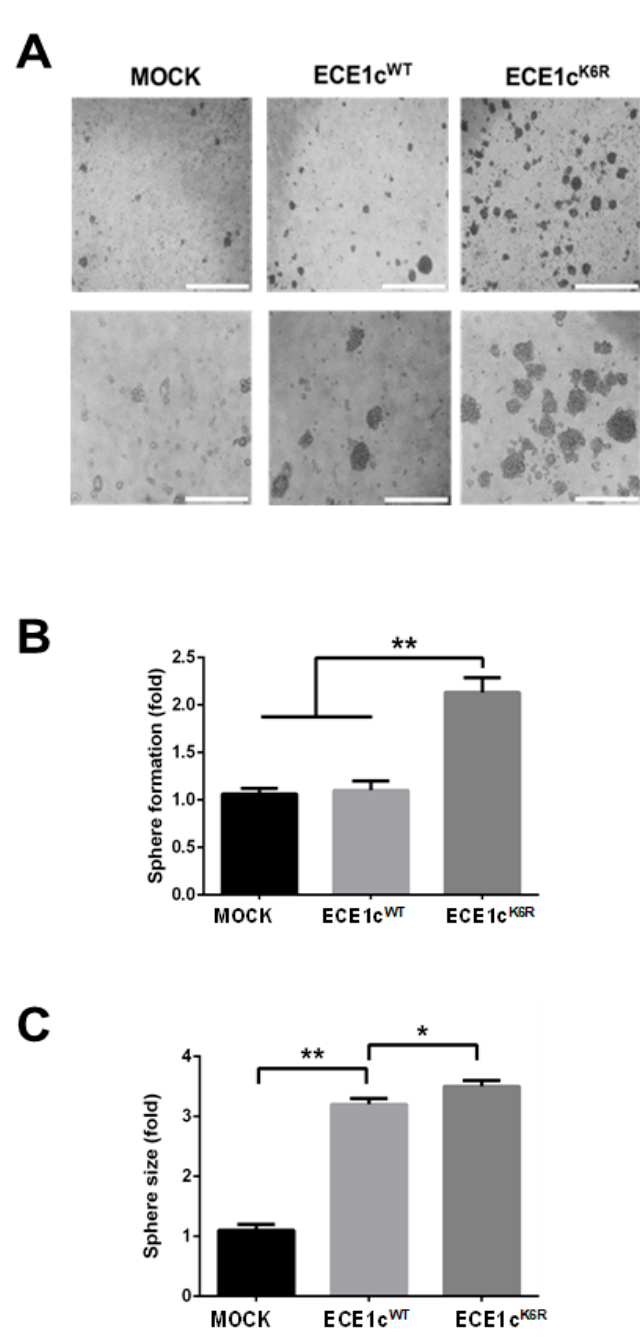
Figure 4. GSC enrichment was promoted by ECE1c K6R . ( A ) GSC enrichment was assessed using U87MG clone cells expressing ECE1c WT or ECE1c K6R and mock cells after 24 h of growth in a neurobasal medium for 7 days (i.e., a neurosphere-forming saturated condition, as detailed in the Materials and Methods). Representative images from three independent experiments are shown. ( B ) The number of spheres formed in A was determined from a triplicate analysis. ( C ) The sizes of the spheres formed in A were quantified from a triplicate analysis. Data represent averages ± SEMs ( n = 3). Peritz F and Student’s tests were used. * p ≤ 0.05, ** p ≤ 0.01.